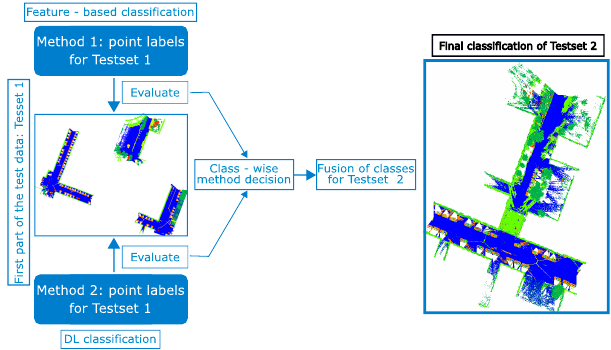
Figure 3. Overview of the method for fusion of feature-based and DL classification Obtaining the final, fusioned output involves four major